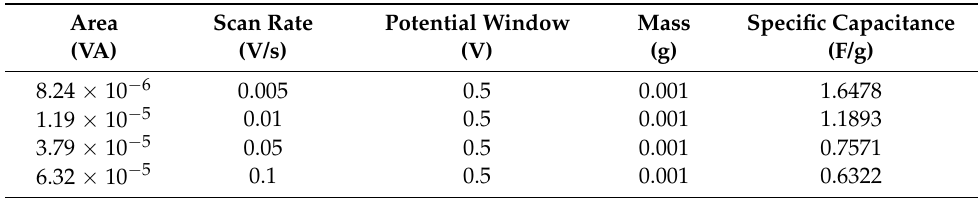
Table 1. Calculated values of specific capacitance of CeO 2 /NiO nanocomposites at different scan rates.